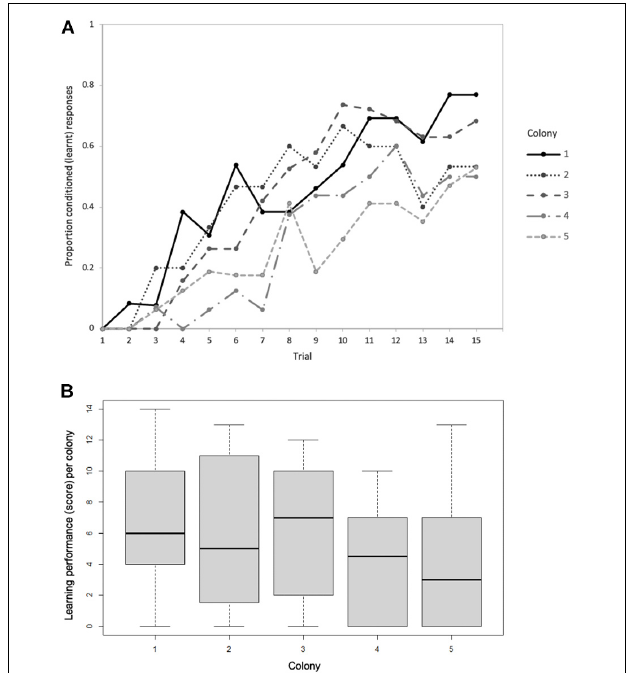
FIGURE 2 | (A) Proportion of conditioned (learnt) responses of Bombus terrestris individuals from five (natal) colonies during 15 sequential proboscis extension response (PER) trials. (B) Variation in learning performance (learning score) of the five natal colonies based on the number of learnt responses per bee. In each box the thick horizontal bar is the colony median, whilst the lower and upper edges represent the 25 and 75% quartiles, respectively. Whiskers indicate the maximum and minimum values that are not outliers. The numbers of bees tested per colony = 13, 15, 19, 16, and 17, respectively.